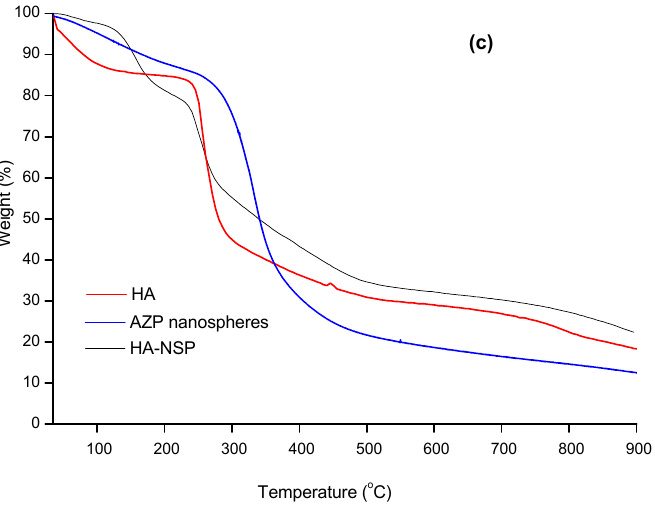
Figure 6. TGA thermograms of ( a ) zein, AZP and DHAB, ( b ) gelatin, IgG and IgG loaded AZP nanospheres and ( c ) HA, AZP nanospheres and HA-NSP.